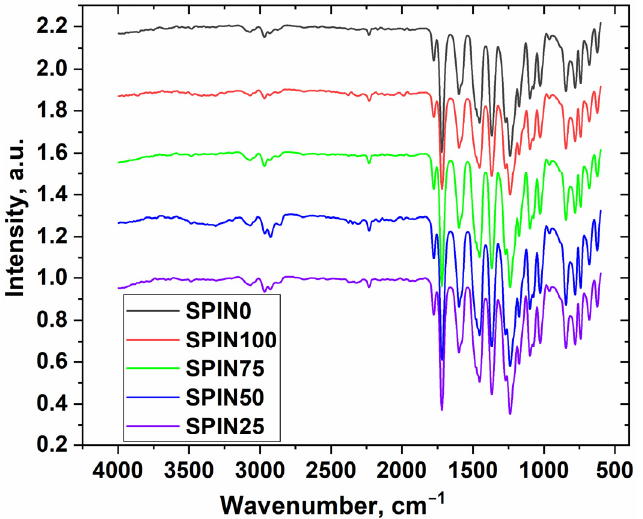
Figure 4. FTIR spectra of the pristine PI film, SPIN0 and PI-based supramolecular films SPIN25, SPIN50, SPIN75 and SPIN100.